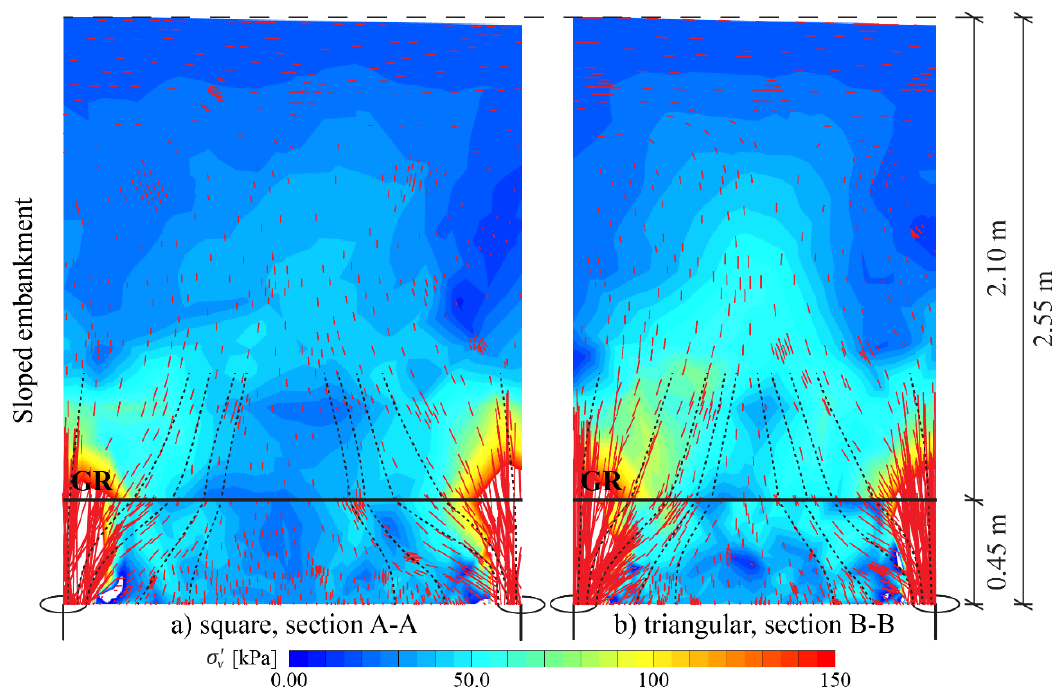
Figure 13. Cross sections of the modelled sloped embankments with 𝑠 = 1.4 m (marked in Figure 12), showing the distribution of 𝜎 𝘷(cid:4593) and 𝜎 (cid:2869)(cid:4593) -vectors. The 𝜎 (cid:2869)(cid:4593) -vectors, projected on a vertical plane, are marked as red lines and their directions are outlined with dashed lines.